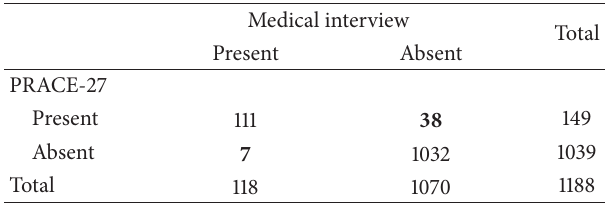
Table 2: Comorbid ailments captured and missed by medical interview (MI) and PRACE-27 in individual organ systems.